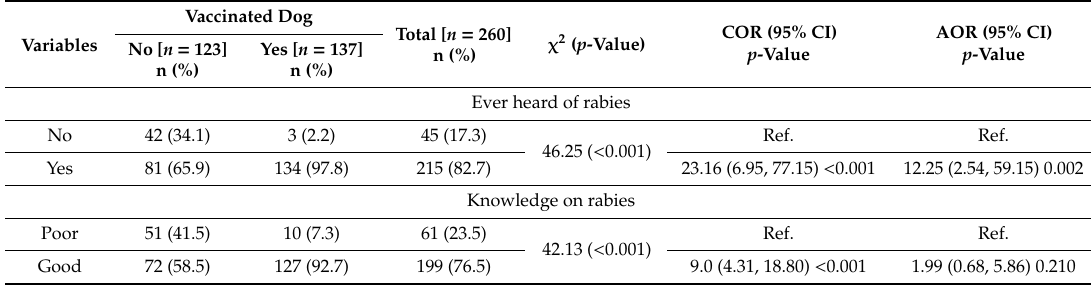
Table 5. Association between awareness and knowledge on rabies and the vaccination of dogs against rabies and the odds of dog